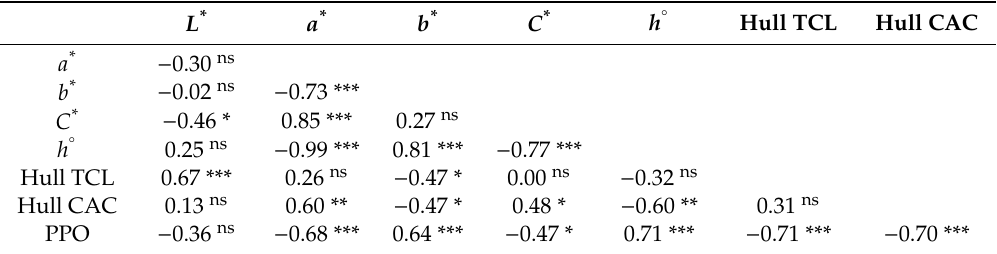
Table 6. Correlation coe ffi cients between external hull color parameters ( L * , a * , b * , C * , h chlorophylls (hull TCL) and carotenoids content (hull CAC), and PPO activity in the hull tissue of fresh